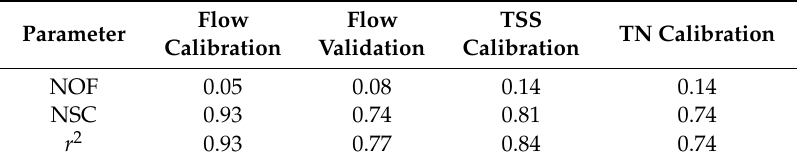
Table 3. The goodness-of-fit test results to evaluate the reliability of the model.